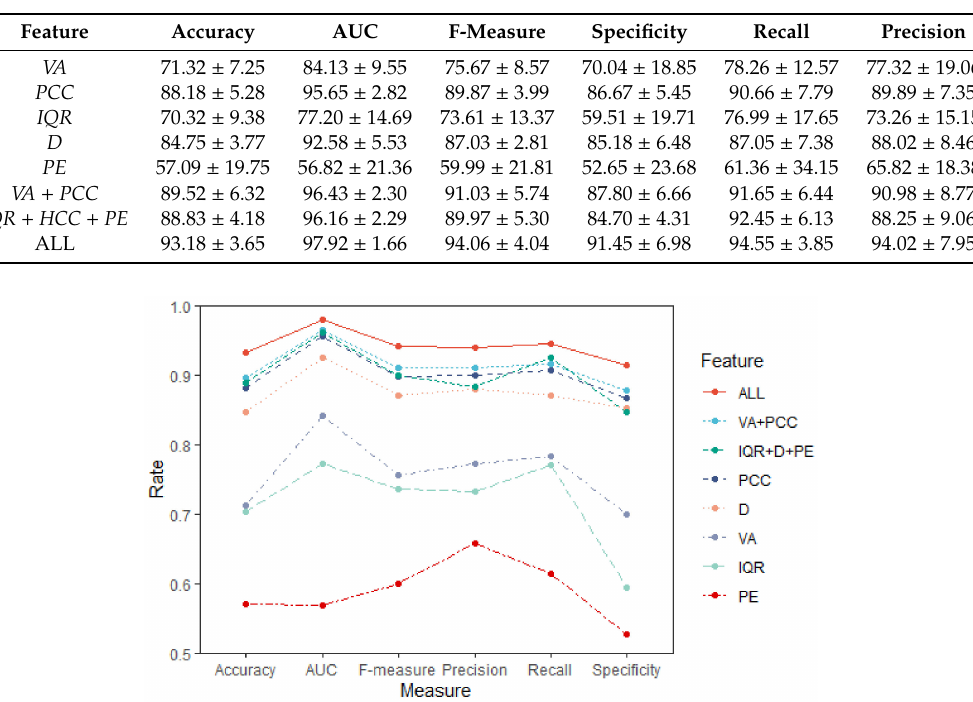
Table 4. Discriminant results by di ff erent features using five-fold CV and LDA based on LA8 wavelet filter (mean ± standard deviation, %).